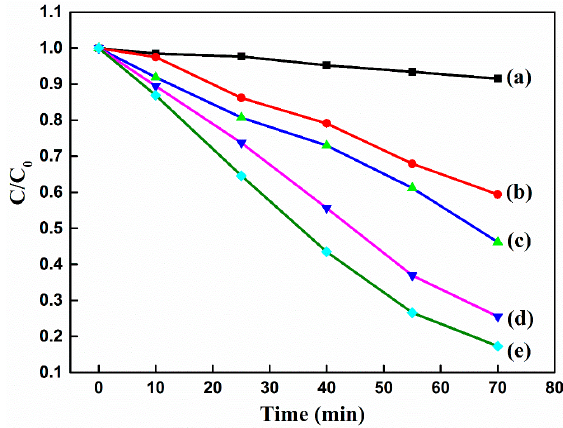
Figure 9. The remaining methylene blue (MB) in solution equilibrated with: ( a ) no catalyst; ( b ) pure WO 3 ; ( c ) WO 3 /GR-0.1; ( d ) WO 3 /GR-0.5; and ( e ) WO 3 /GR-1 after stirring in the dark for 60 min.